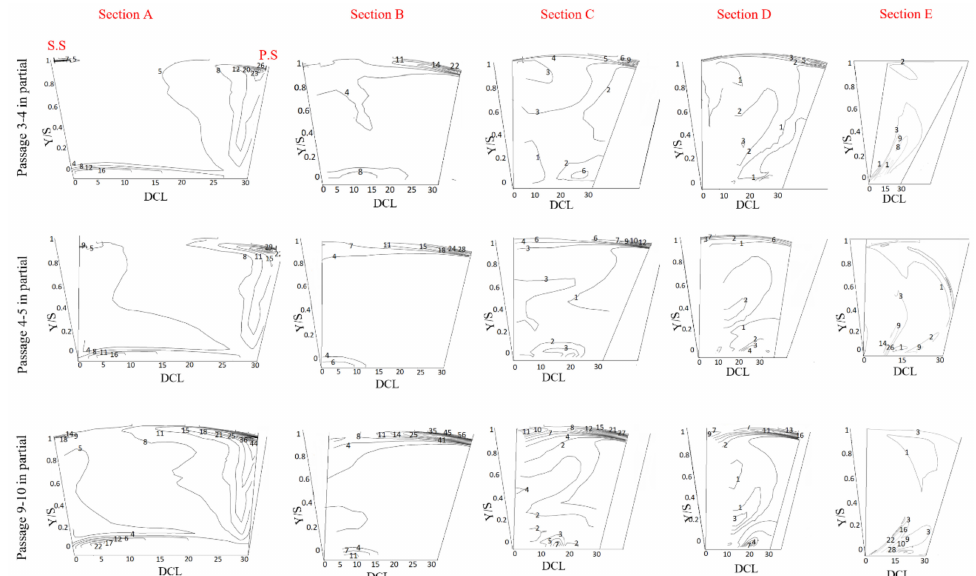
Figure 9. Vorticity contours at specified sections in blade passages 3–4, 4–5, and 9–10 of the partial case in the spanwise location against the degree in circumferential location